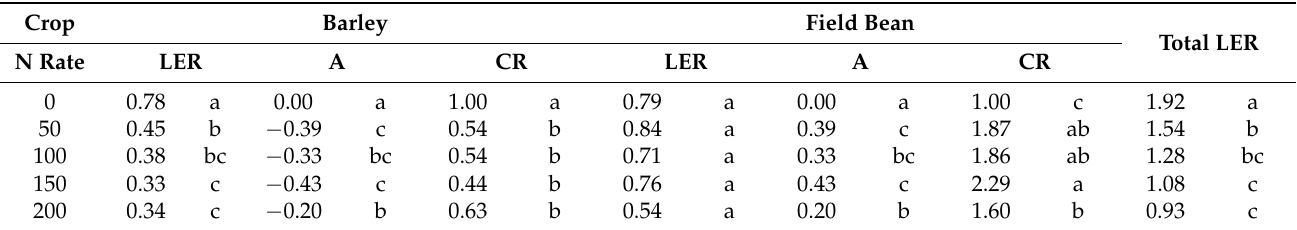
Table 4. Nitrogen rate main effect on partial land equivalent ratio (LER), competitive ratio (CR), and